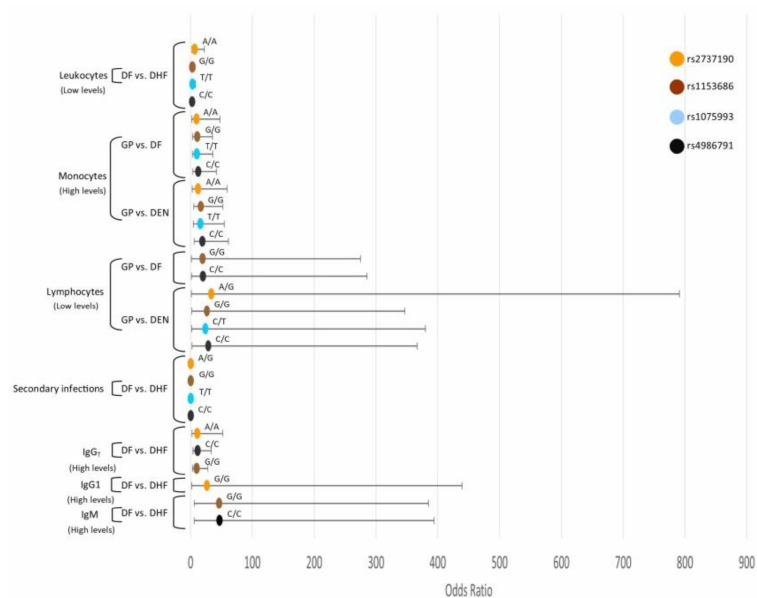
Figure 2. Interaction analysis of TLR 4 SNPs and the hematological covariates. Interaction analysis of TLR4 SNPs and the levels of hematological covariates leukocytes, lymphocytes, monocytes, and immunoglobulin levels of IgM, total IgG, IgG1, and secondary dengue infections. Odds ratios and confidence intervals are shown in abscissa axis and genotypes are indicated above the odds ratios